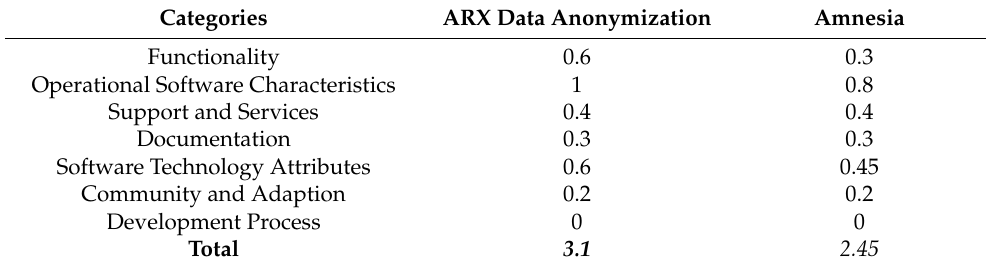
Table 4. Category Results.